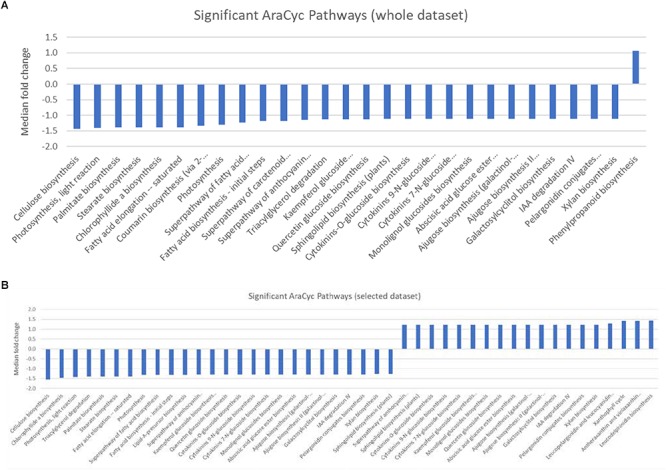
(A,B) Graphic showing the median fold change of genes associated with significantly over-represented AraCyc pathways identified from (A) either the entire dataset, or (B) selected genes that were preferentially expressed in either the central population relative to the northern population (positive values) or genes that were preferentially expressed in the northern population (negative values).